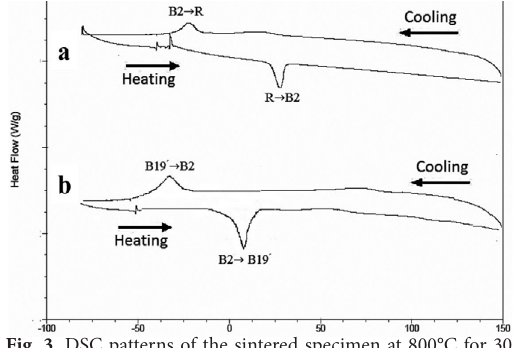
Fig. 4. The pressure test results of the sintered specimen at 800°C for 30 min (a), and the sintered specimen at 800°C for 120 min